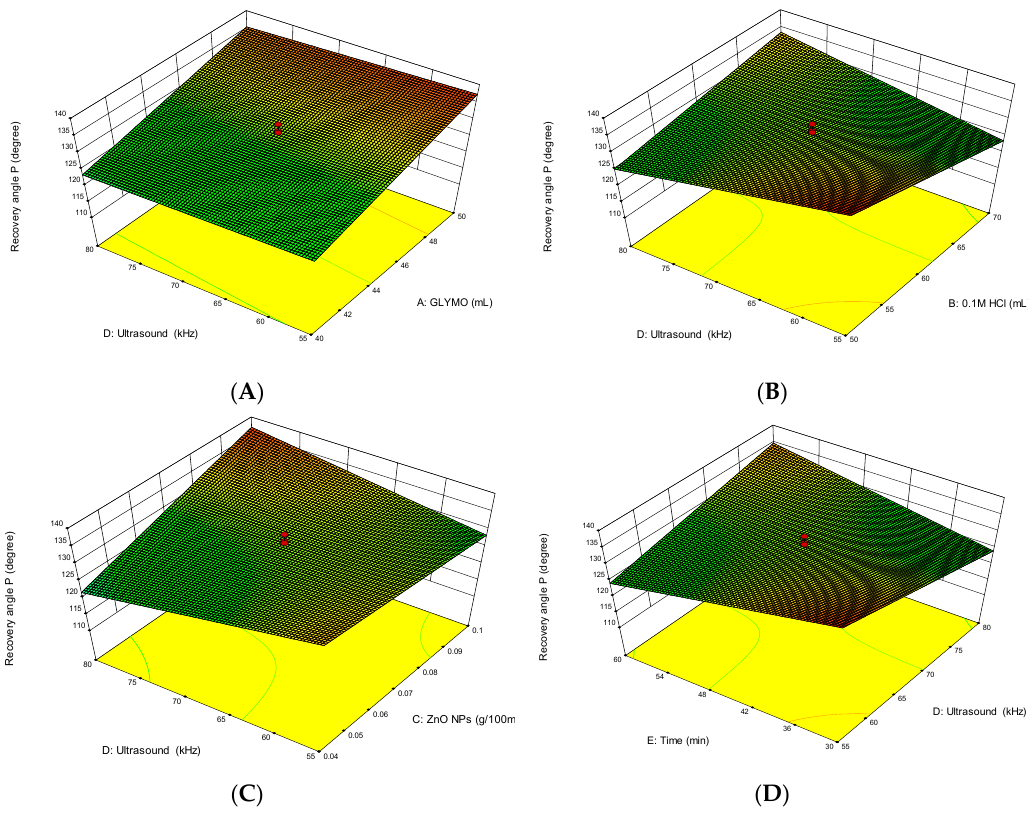
Figure 4. Three-dimensional response surface plots for investigating parameters: e ff ects of the ultrasonic irradiation and ( A ) GLYMO, ( B ) HCl, ( C ) ZnO nanoparticles and ( D ) time on the obtained modified cellulose.